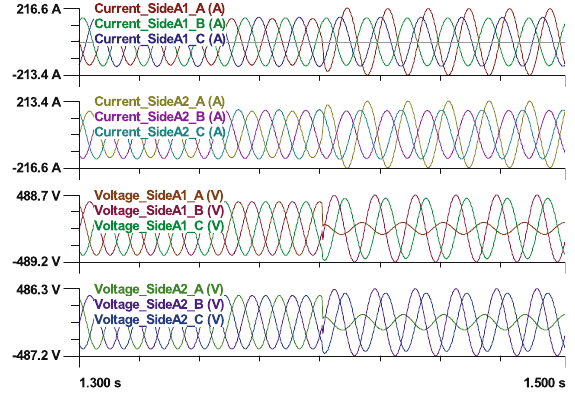
Fig. 14 Calculated current phasor ratio trance of event 3: external bolted fault, grid-connected mode